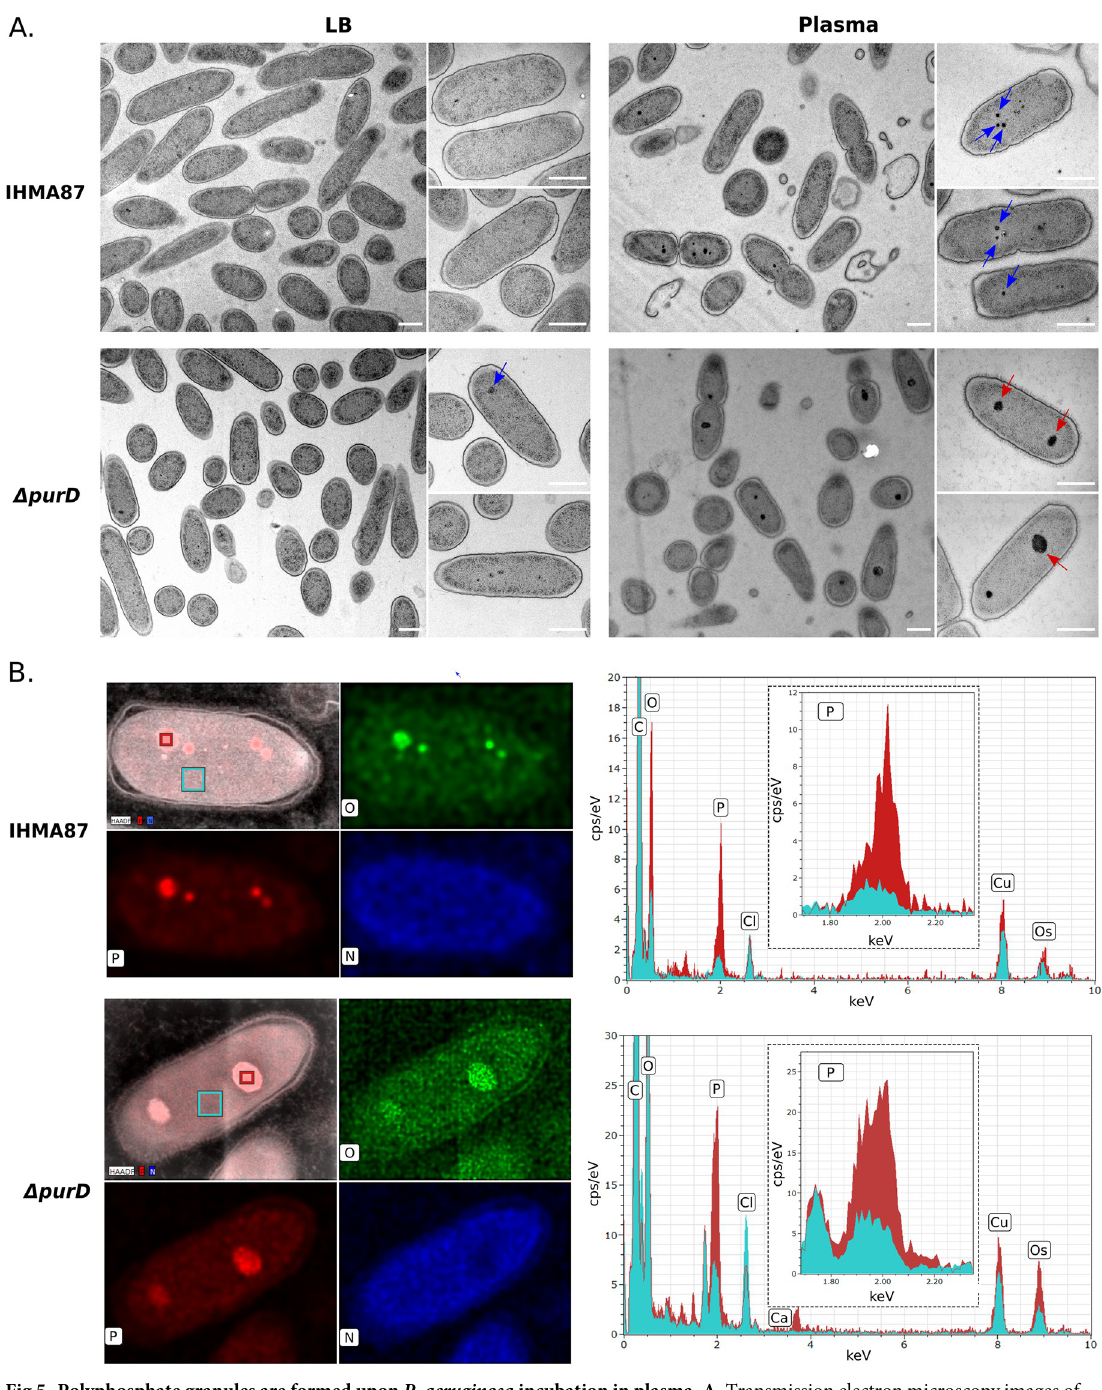
Fig 5. Polyphosphate granules are formed upon P . aeruginosa incubation in plasma. A. Transmission electron microscopy images of indicated strains after growth in LB (left) or 1h-incubation in human plasma (right). Red and blue arrows show big- and small-sized granules respectively. Scale bar = 500 nm. B. EDX elemental composition maps of oxygen (green), phosphorus (red) and nitrogen (blue) of IHMA87 wild-type and Δ purD in plasma (left). EDX spectra (right) of highlighted locations (red = granules, cyan = cytoplasm), major peaks are assigned. Data show elevated levels of phosphorus and oxygen in the granule, indicating that the identified objects are polyP.